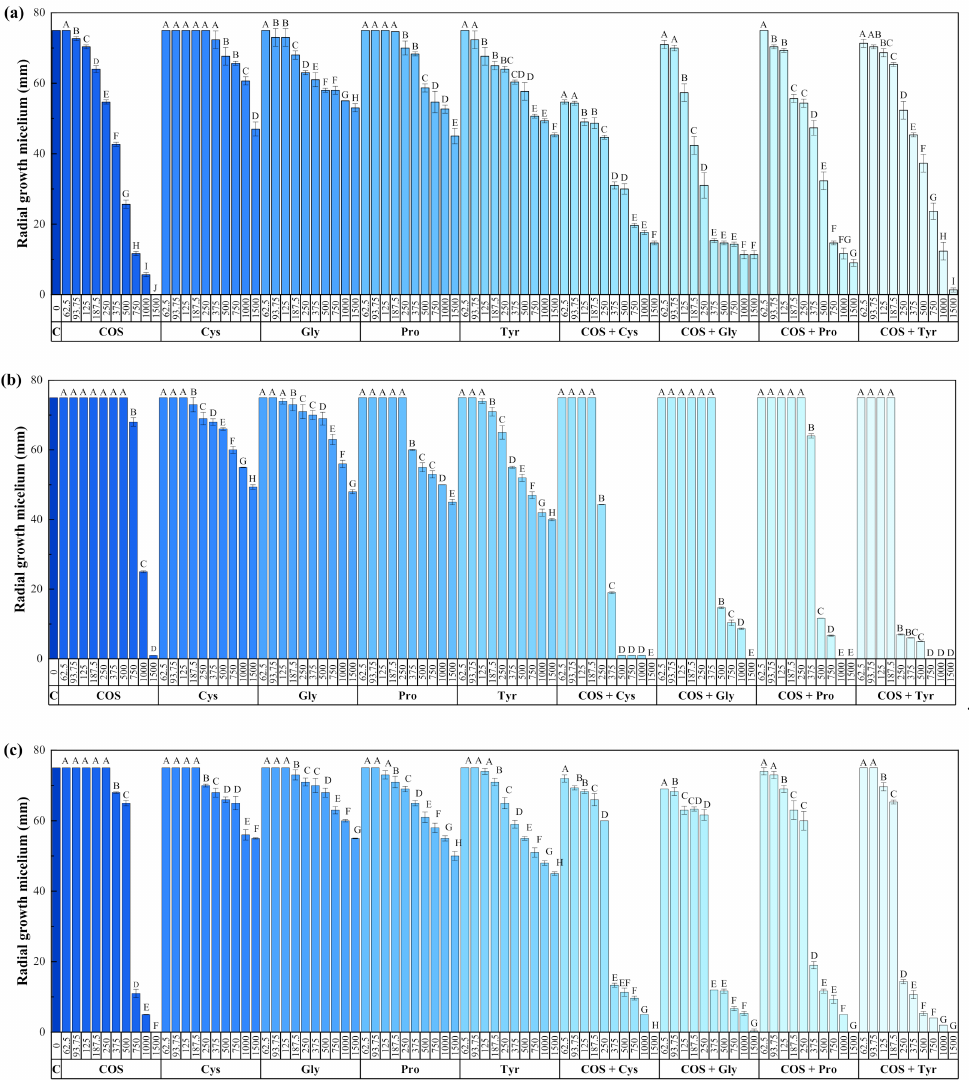
Figure 2. Colony growth values of ( a ) N. parvum , ( b ) D. seriata and ( c ) B. dothidea strains when cultured in PDA plates containing several control products, i.e., chitosan oligomers (COS), cysteine (Cys), glycine (Gly), proline (Pro), tyrosine (Tyr), and the respective COS–amino acid (1:1 v / v ) conjugate compounds. The same letters above concentrations mean that they are not significantly different at p < 0.05. Error bars represent standard